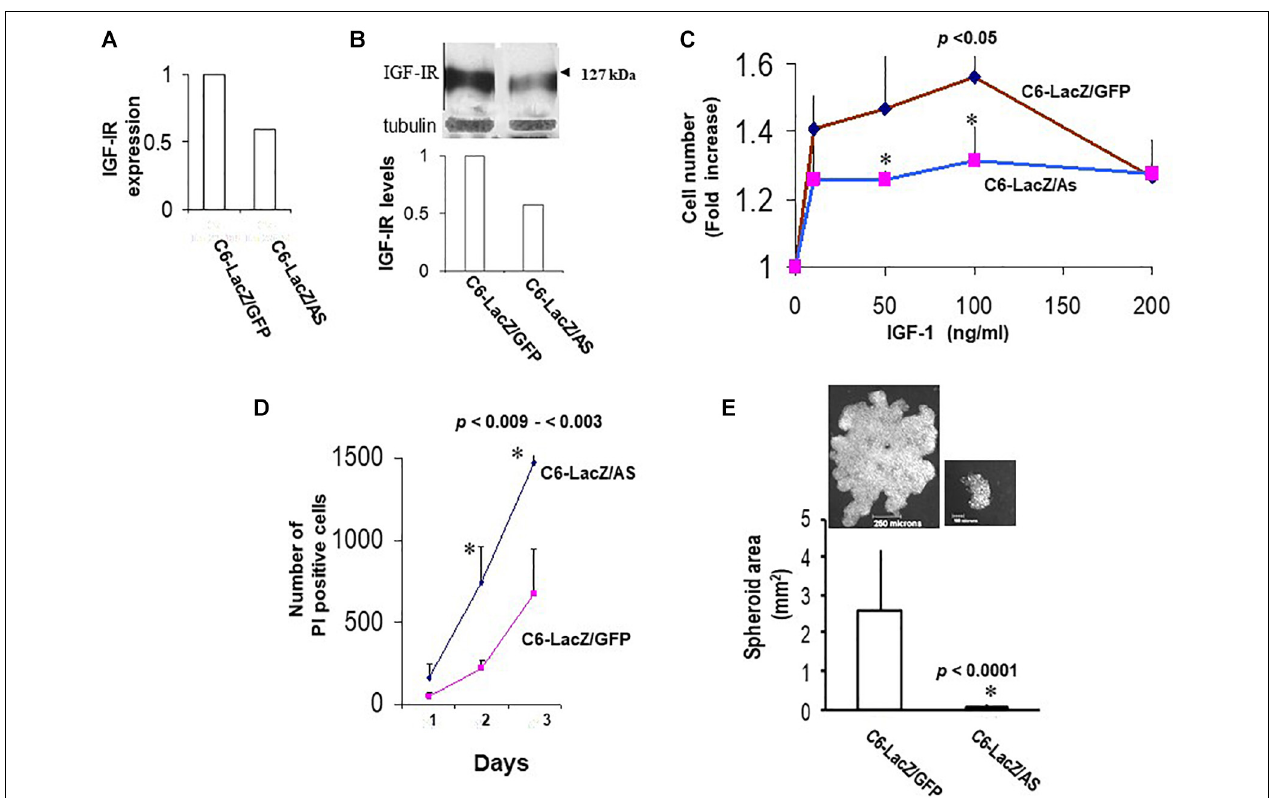
FIGURE 2 | Reduced IGF-IR expression in virally transduced C6 cells affects multiple IGF-I – regulated functions. IGF-IR mRNA expression levels (A) were measured by RT-PCR. Representative results of densitometry analysis ( n = 2) shown in the bar graph are expressed as the ratios of the densities of IGF-IR:L19 bands relative to control C6/LacZ GFP cells that were assigned a value of 1. Protein levels (B) were analyzed by Western blotting. Representative results of laser densitometry, shown in the bar graph ( n = 2) are expressed as the ratios of IGF-IR:tubulin bands relative to C6/LacZ GFP cells that were assigned a value of 1. Cell proliferation (C) was measured by the MTT assay. Shown are the results of a representative experiment of 3 performed. Data are expressed as the means and SD of triplicate samples ( ∗ p < 0.05 for 50 and 100 ng/ml IGF-I). Cell survival in IGF-I containing medium (D) was analyzed by PI staining. Glioma cells were plated in 4-chamber slides, first in complete medium and then in serum-free RPMI medium containing 100 ng/ml rhIGF-I. PI (1 mg/ml) was added to the chambers for 5 min at 37 ◦ C, on days 1–3 and the PI-permissible (dead) cells enumerated using an inverted microscope. Data are expressed as means ( ± SD) of triplicate samples ( ∗ p < 0.003 and p < 0.009 for days 2 and 3, respectively). Shown in (E) are means ( ± SD) of total spheroid surface area for the indicated cells. Images of representative spheroids for each of the cells are shown on